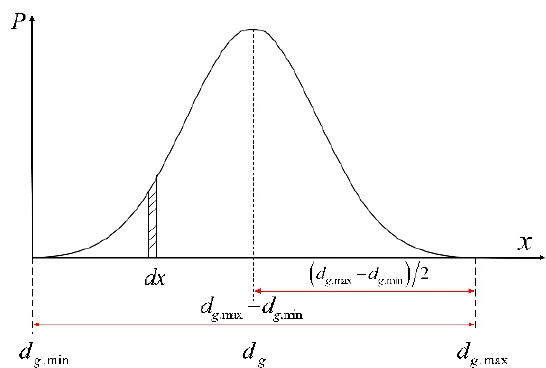
Figure 4. Normal distribution curve of abrasive particle diameter.